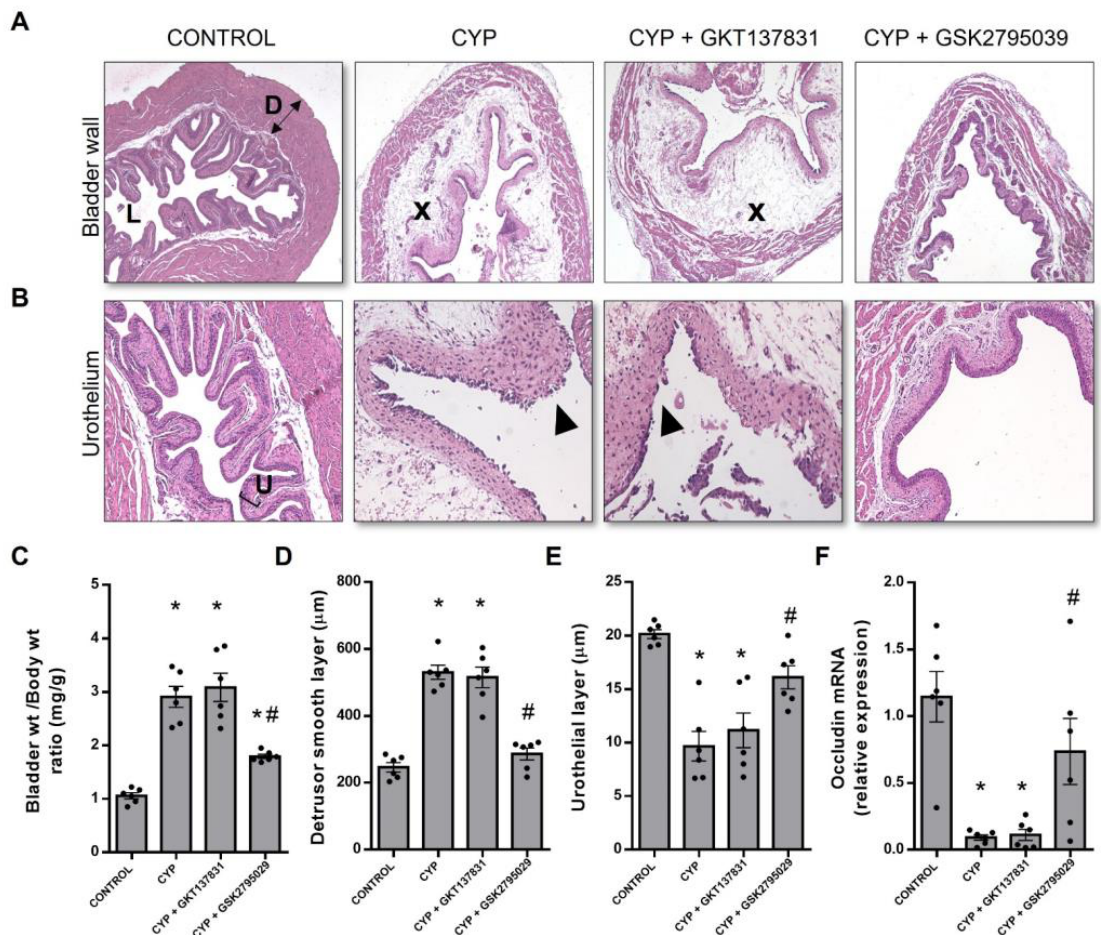
Figure 3. Histological examination of hematoxylin–eosin-stained bladder sections of the control (saline) and cyclophosphamide (CYP, 300 mg/Kg, ip, 24 h)-injected animals untreated or treated (three doses in 24 h) with the NOX1/4 inhibitor GKT137831 (5 mg/Kg, ip) or NOX2 inhibitor GSK2795039 (5 mg/Kg, ip). The upper panel shows the bladder wall (( A ), 5× magnification) while the lower panel highlights the urothelium ((B), 20× magnification). The bladder weight/total body weight ratio ( C ) were determined. The thickness of the detrusor smooth muscle and urothelial layers are shown in ( D , E ), respectively. The mRNA expression levels of occludin ( F ) were determined by RT-PCR and expressed as relative to the housekeeping genes. Summary data (mean ± SEM) represent n = 6 for all of the groups. Significance was tested by two-way ANOVA followed by multiple comparisons by Tukey ’s post -hoc test. * p < 0.05 vs. CONTROL; # p < 0.05 vs. CYP. D, detrusor smooth muscle; L, lumen; U, urothelium. The ‘x’ highlights severe edema and the arrowhead highlights urothelial den- udation.